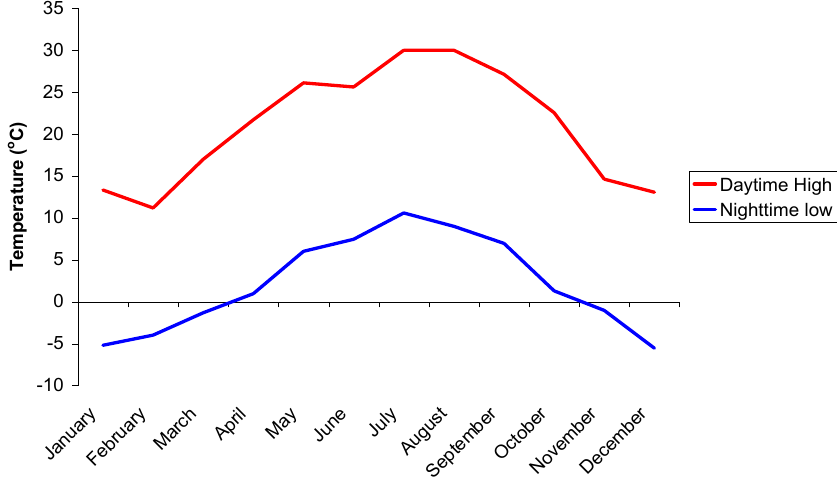
Figure 4. Daytime highs and nighttime lows in temperature of the Paris environment throughout one year.